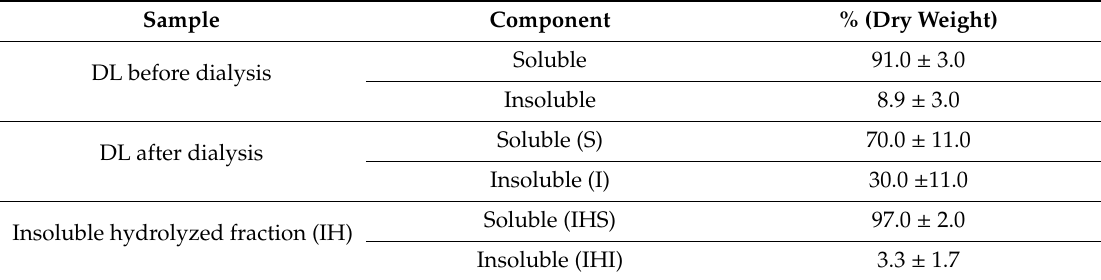
Table 1. Composition of soluble (S) and insoluble (I) fractions in DL before.and after dialysis ( α ≤ 0.05).